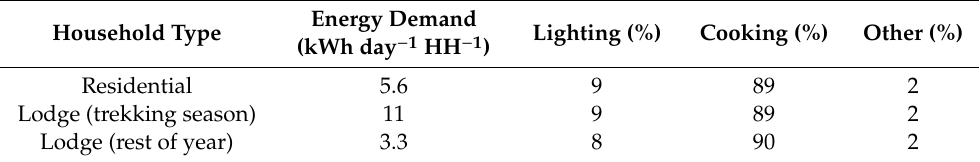
Table 3. Energy demand of di ff erent household types, as per household HH. Adapted from Proietti et al.